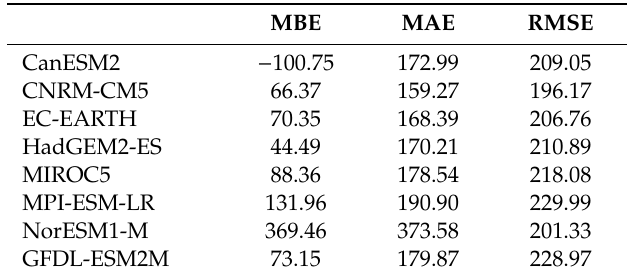
Figure 8. Third quarter total rainfall evolution. Table 11. Results of statistical criteria for third quarter total precipitation.